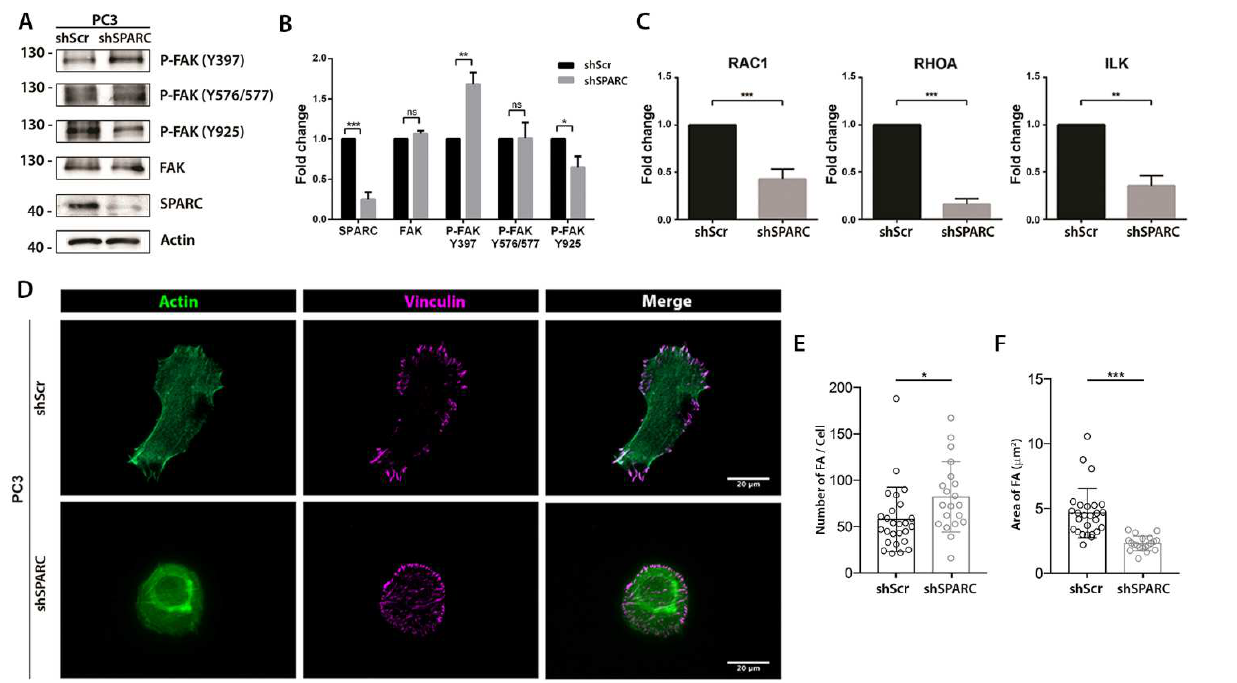
Figure 4. Effect of SPARC knockdown on the phosphorylation status of focal adhesion kinase (FAK) and the formation of focal adhesions ( A ). Representative Western blot of FAK, phosphorylated FAK (P-FAK) and SPARC expression in PC3 cells transduced with a lentiviral vector carrying a short hairpin RNA against SPARC (shSPARC) or a scrambled sequence (shScr) ( B ). Quantification of the optic density of the Western blot shown in ( A ). Protein expression was normalized to β-actin and control cells ( C ). Relative expression of RAC1, RHOA, and ILK measured by RT-qPCR in PC3 shScr and PC3 shSPARC cells. Relative expression was normalized to pumilio and control cells (first col- umn) using the ΔΔCt method ( D ). Representative images of immunofluorescence vinculin and cy- toskeleton stain with phalloidin in PC3 shScr and PC3 shSPARC cells. Bar = 20 μm ( E ). Quantifica- tion of the number of focal adhesions (FA) per cell in both conditions ( F ). Quantification of the area of FA in both conditions ( B , C , E , F ). Data are expressed as mean ± SD (n = 3). ns = p > 0.05; * = p ≤ 0.05; ** = p ≤ 0.01; *** = p ≤ 0.001; Mann–Whitney U test.